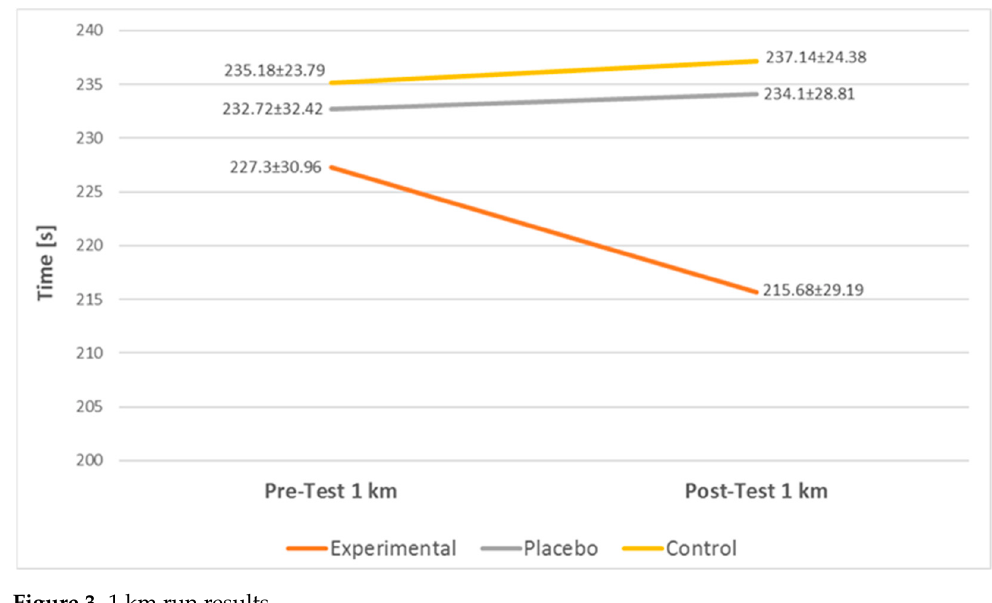
Figure 3. 1 km run results.